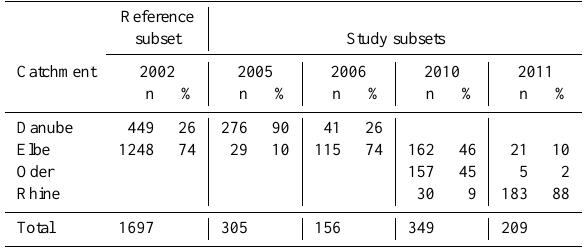
Table 3. Numbers and percentages of interviews with respect to the affected river